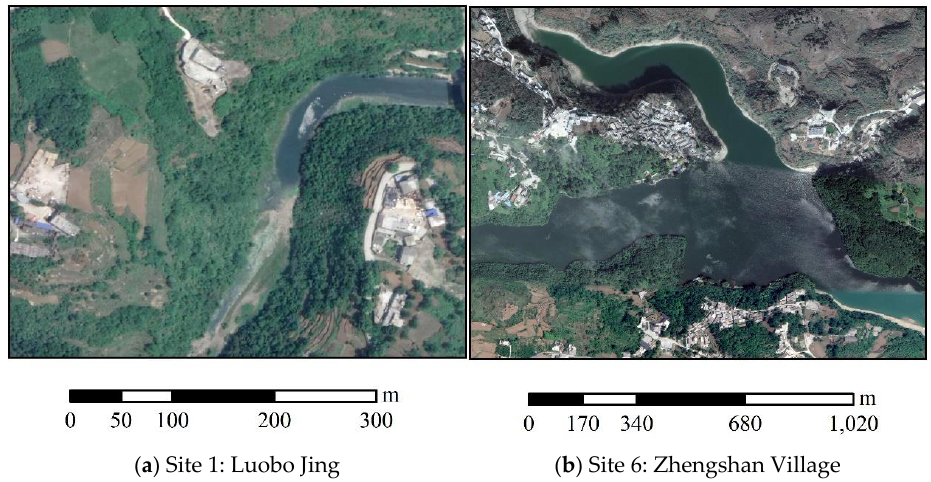
Figure 3. Remote sensing images from Google Earth around high value sampling sites in 2019.